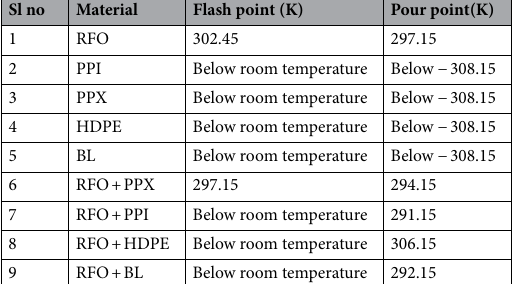
RFO + HDPE Below room temperature